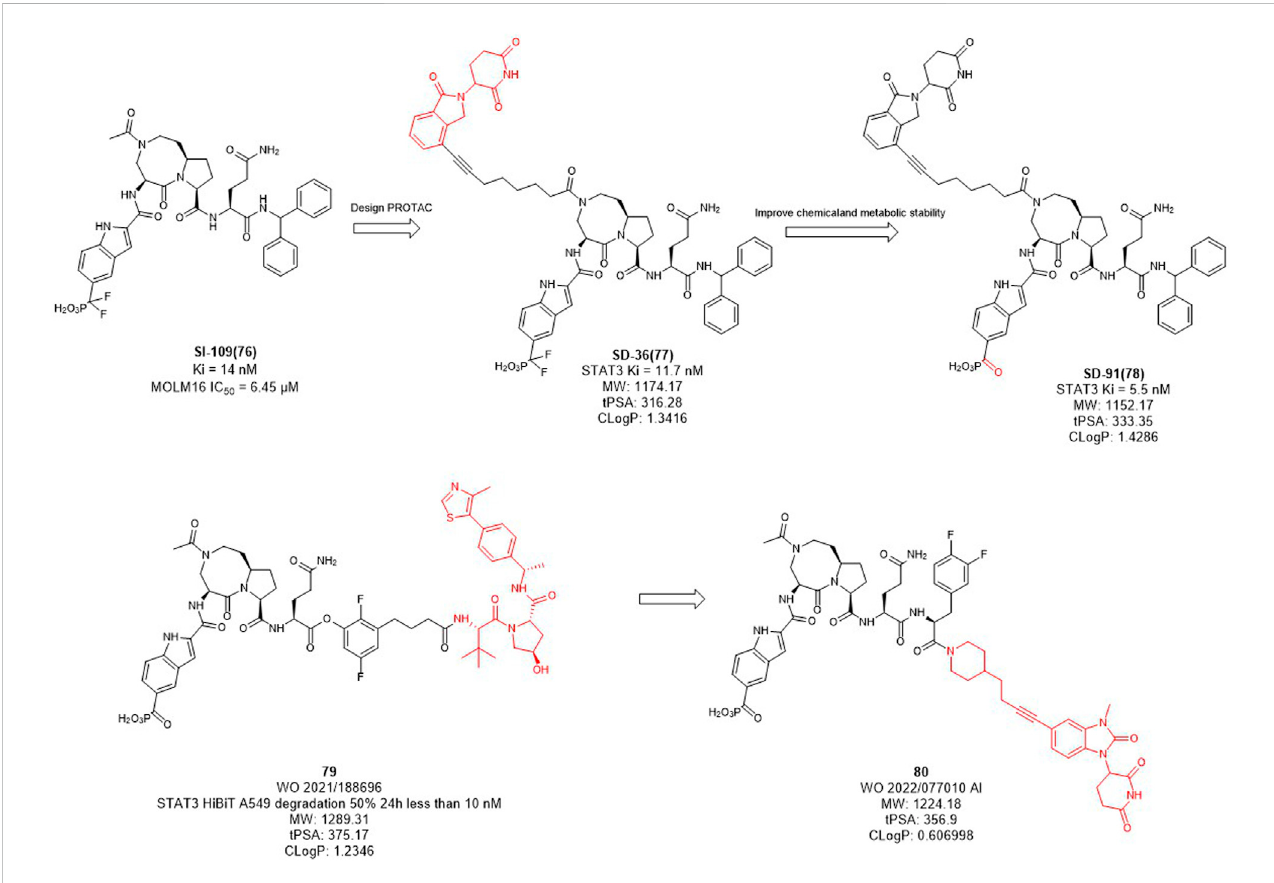
FIGURE 10 Design and optimization of STAT3 PROTACs.